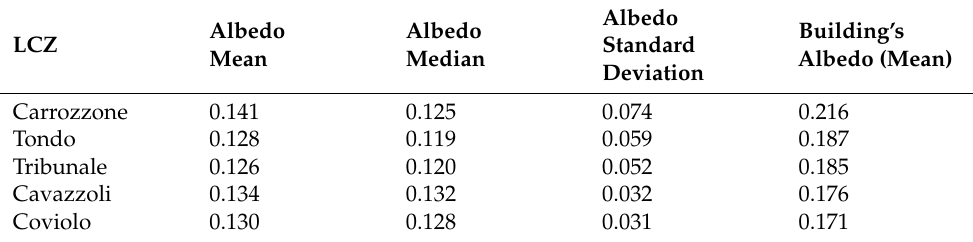
Table 6. Surface albedo statistics for the 5